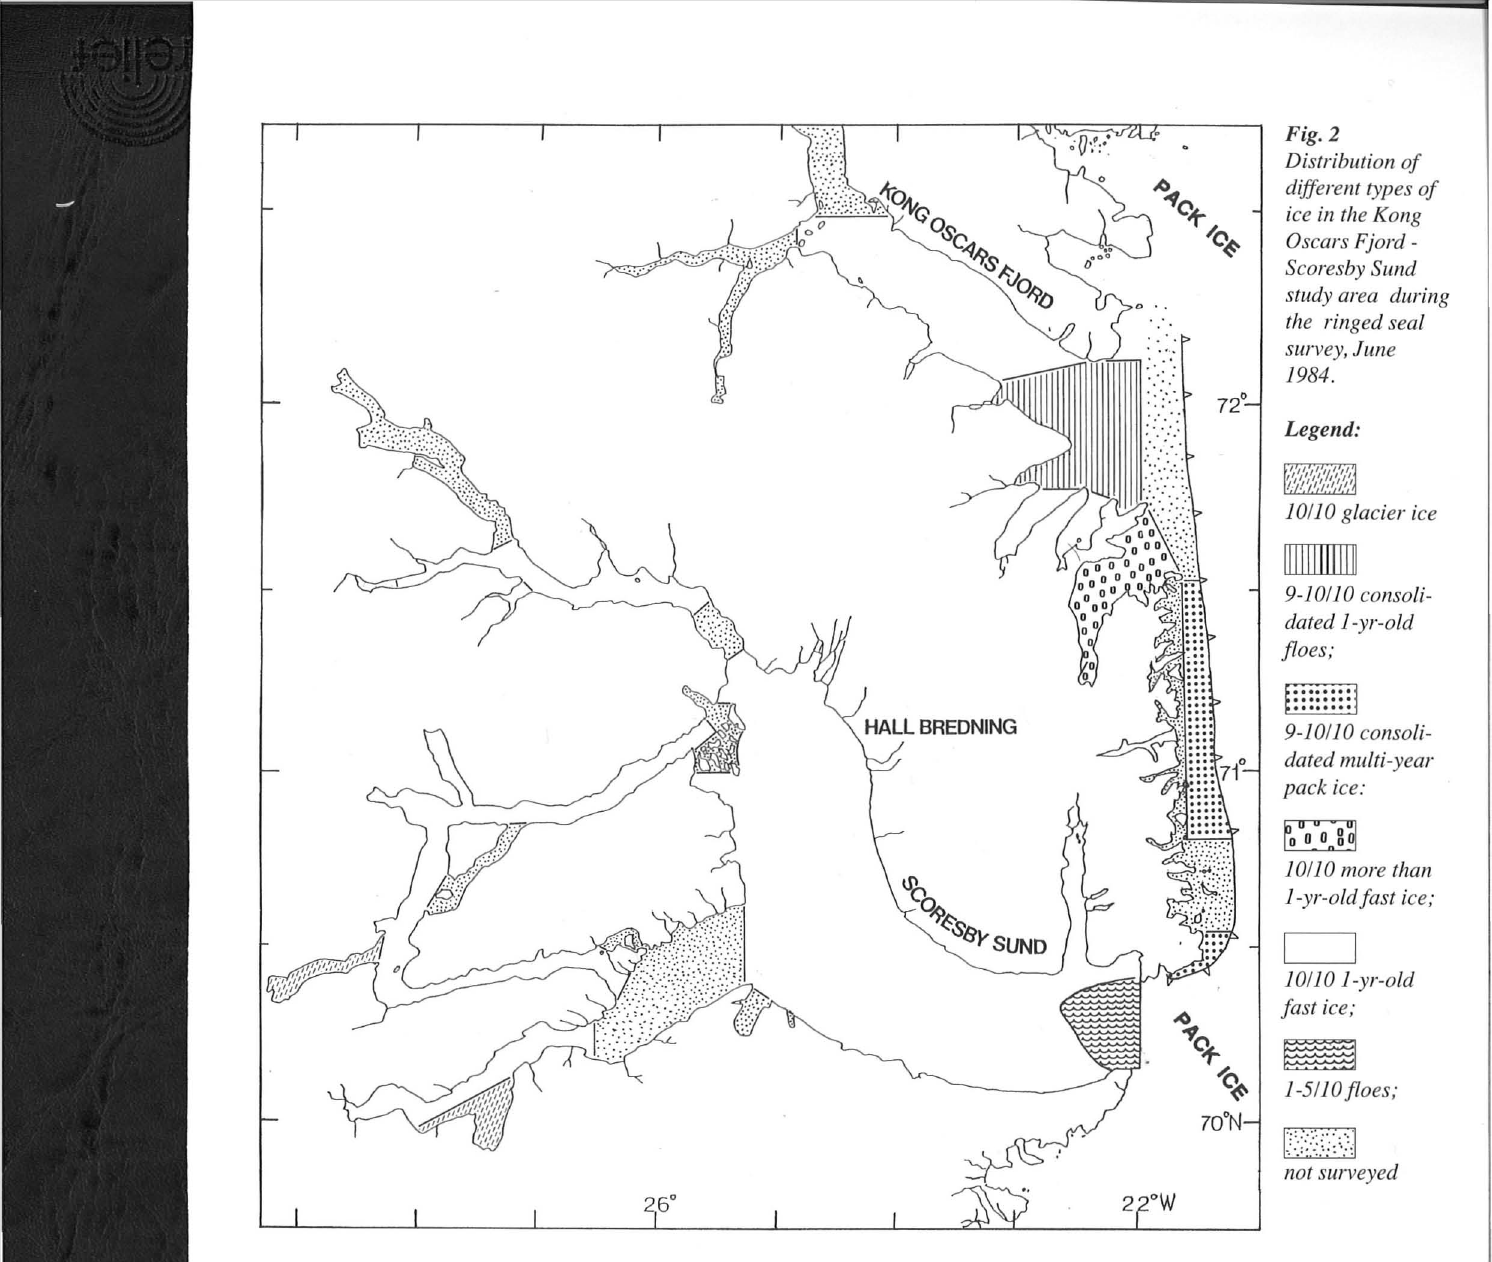
Fig. 2 Distribution of different types